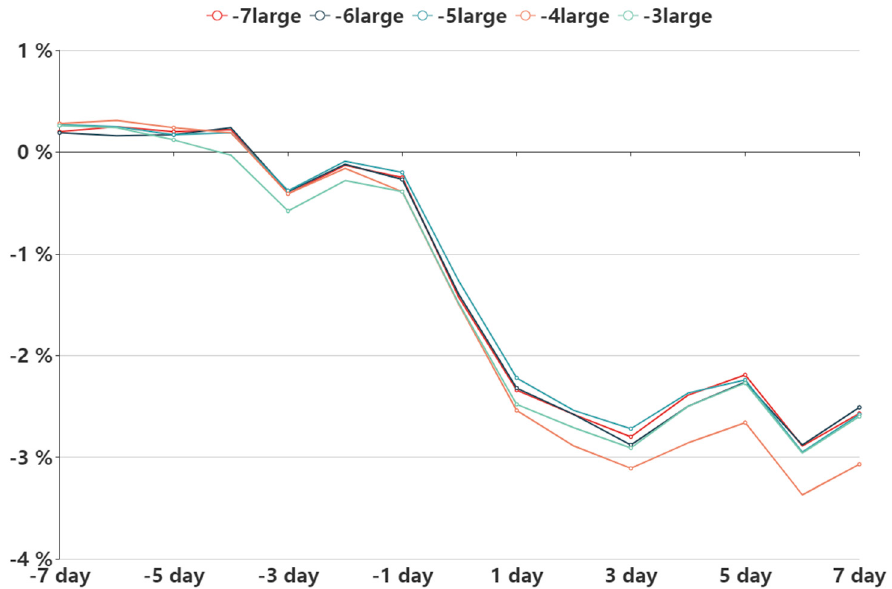
Figure 3. Distribution of the remaining non-larger trading volume groups on different trading days.